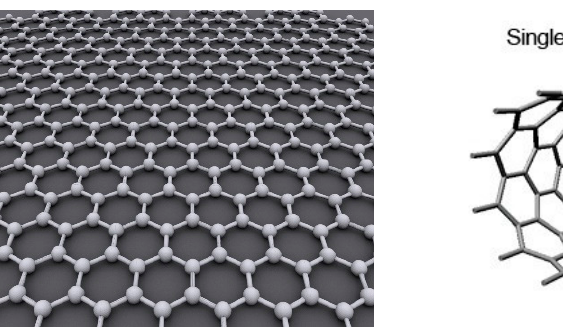
Figure 1. Basic structure of a graphene ( left ) [27], single-walled carbon nanotube ( middle ) and multi-walled carbon nanotube ( right ) [28]. CC BY-SA 3.0. multi-walled carbon nanotube ( right ) [28]. CC BY-SA